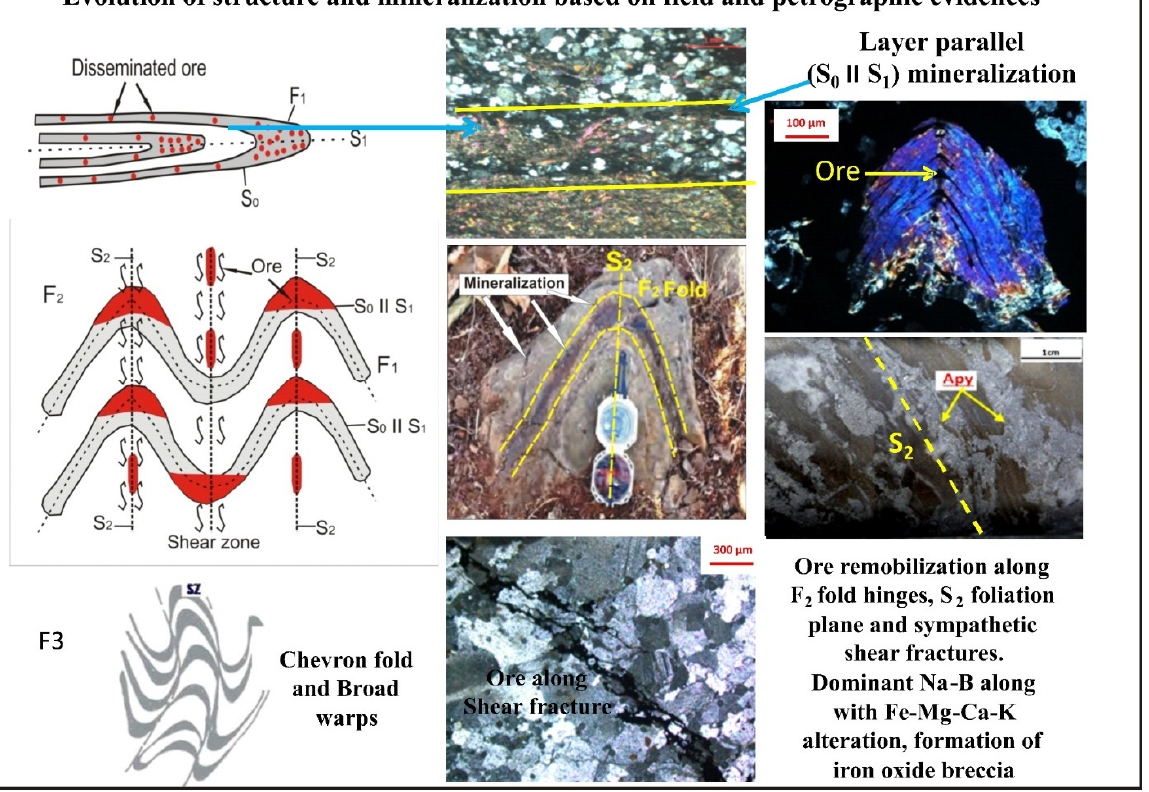
Figure 15. Schematic diagram showing the stage of evolution of the structure and polymetallic min- eralization at theJagpura deposit based on field and petrographic studies. mineralization at theJagpura deposit based on field and petrographic